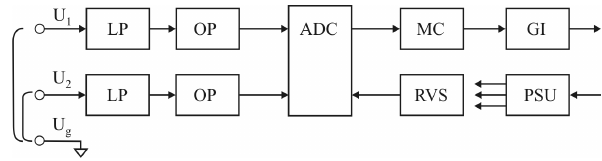
Figure 3. Functional diagram of the LEMI-420 channel for electri- cal measurements. Here: U 1 , U 2 , U g – input voltage; LP – circuit which protects against lightning-induced large voltage; OP – opera- tional amplifier; ADC – analogue/digital converter; RVS – reference voltage source; MC – microcontroller; GI – galvanic isolation; PSU – power supply